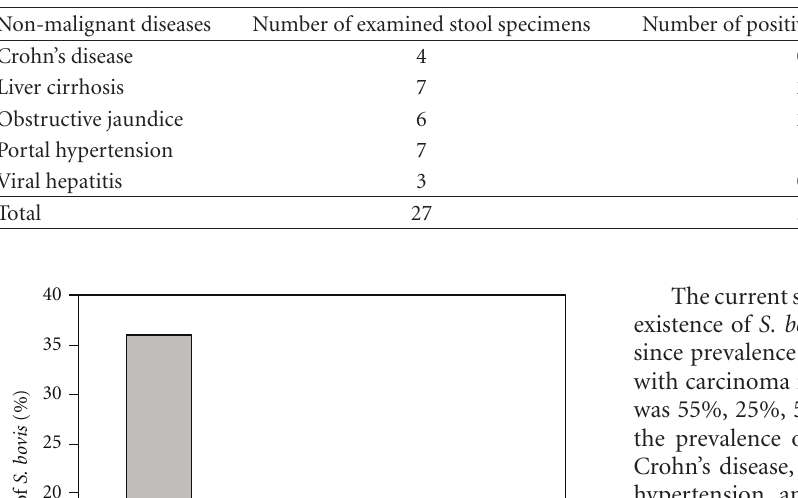
Table 4: Prevalence of S. bovis isolated from patients with non-malignant gastrointestinal diseases.